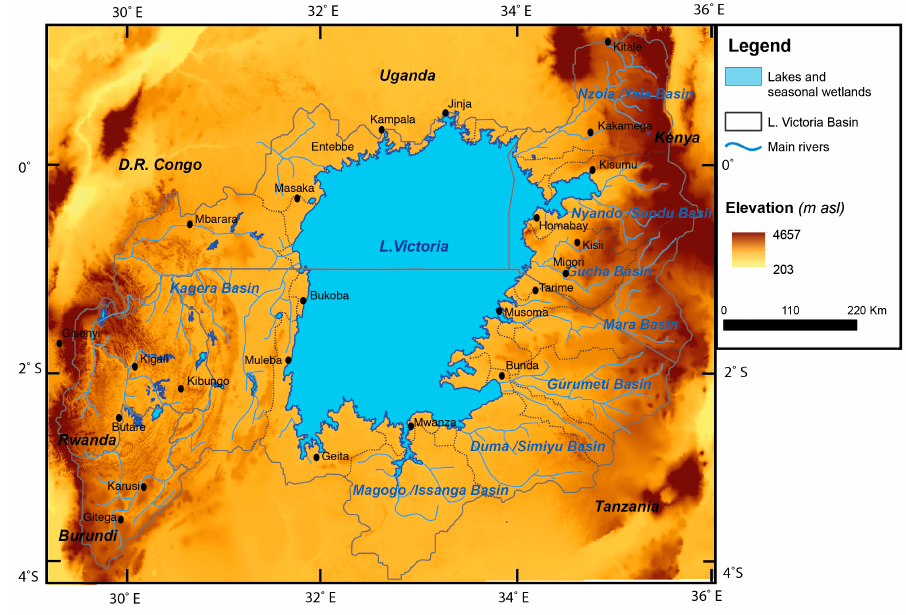
Figure 1. Rivers of the Lake Victoria Basin used in the projection studies.